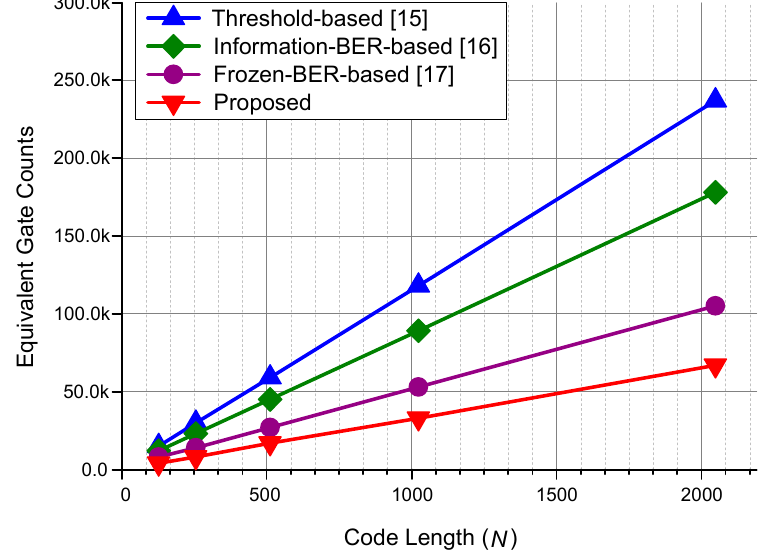
Figure 9. Equivalent gate counts of threshold-based [15], information-BER-based [16], frozen-BER- based [17], and proposed early-termination algorithms according to code length.